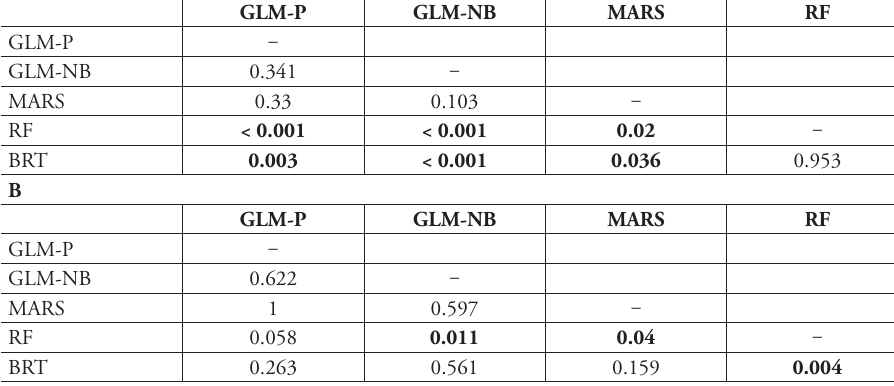
Table 2. Results of pairwise Wilcoxon tests of significant differences for the performance of the tech- niques for predicting absolute richness (as measured by relative absolute error) using leave-one-out cross- validation (A) and regional cross-validation (B). Predictions of GLM-P, GLM-NB and MARS refer to models using ‘clamped’ data (see main text). Significant differences (at α = 0.05) are shown in